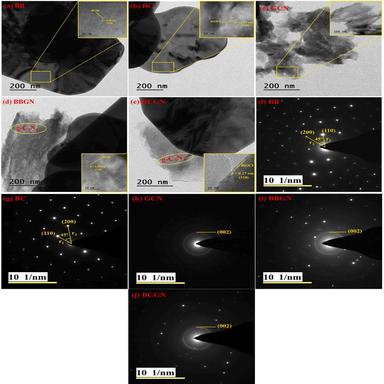
HRTEM images and SAED patterns of (a, f) BB, (b, g) BC, (c, h) GCN, (d, i) BBGN and (e, j) BCGN.